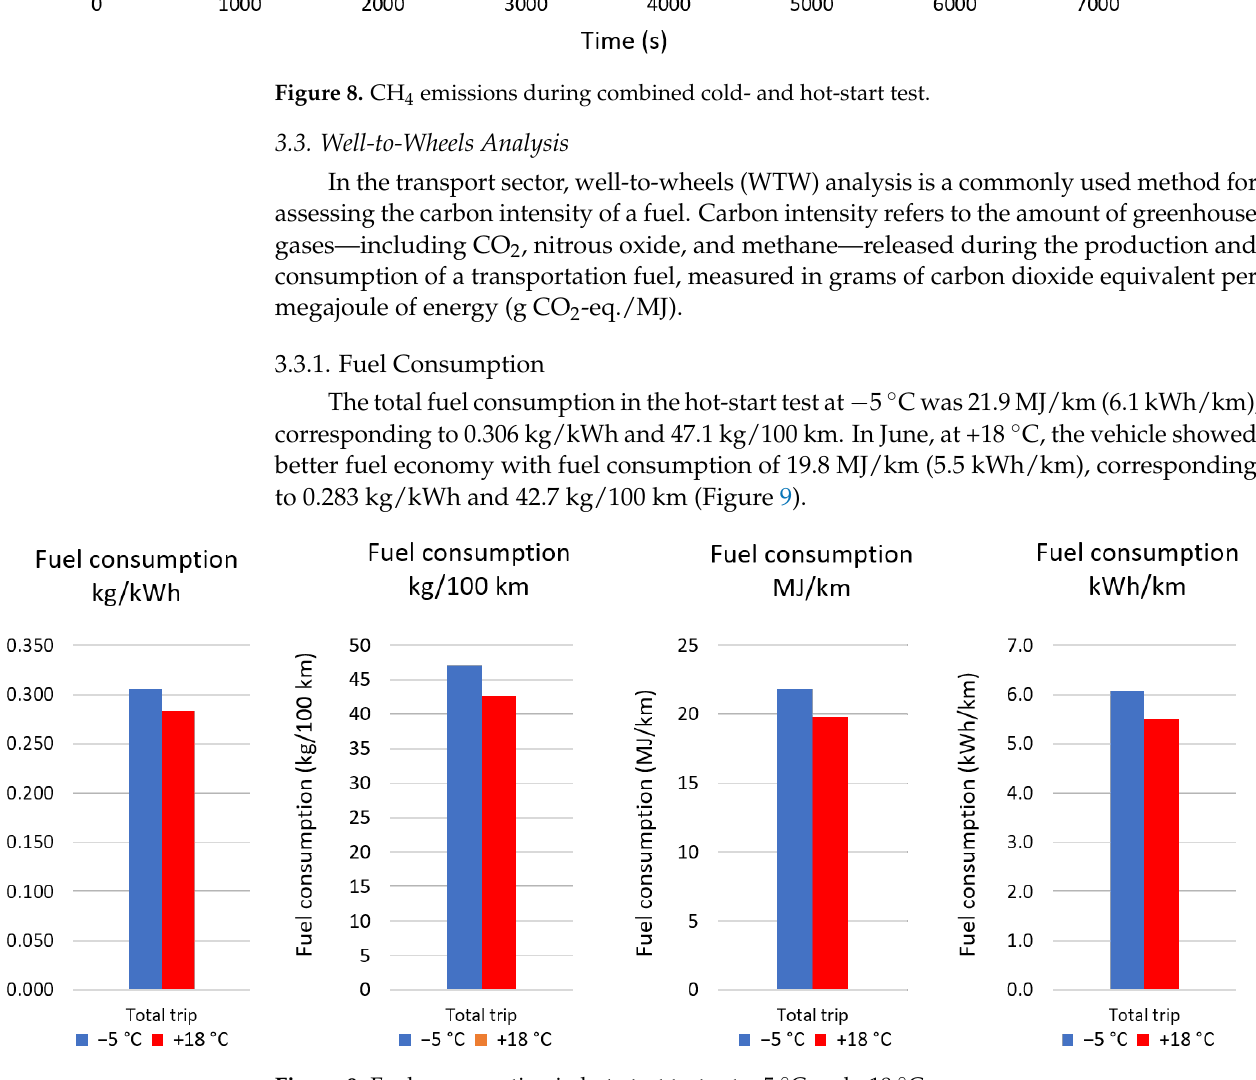
Figure 9. Fuel consumption in hot-start tests at − 5 °C and +18 °C.